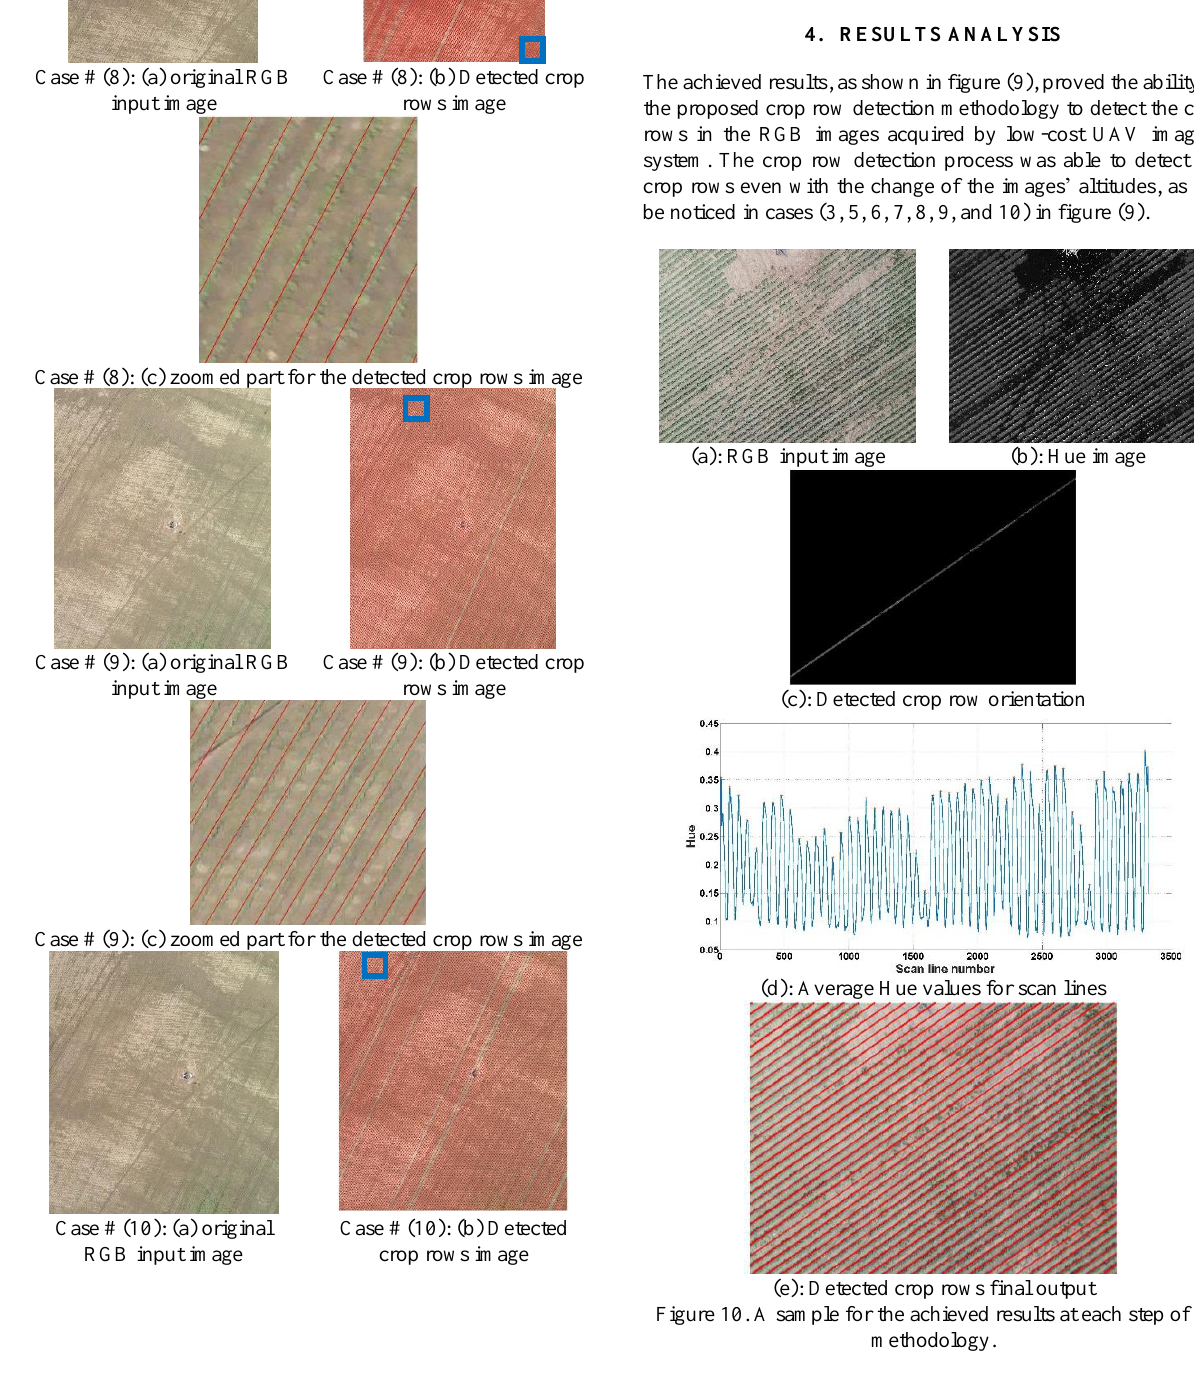
Figure 9. The achieved crop rows detected images from the proposed methodology.